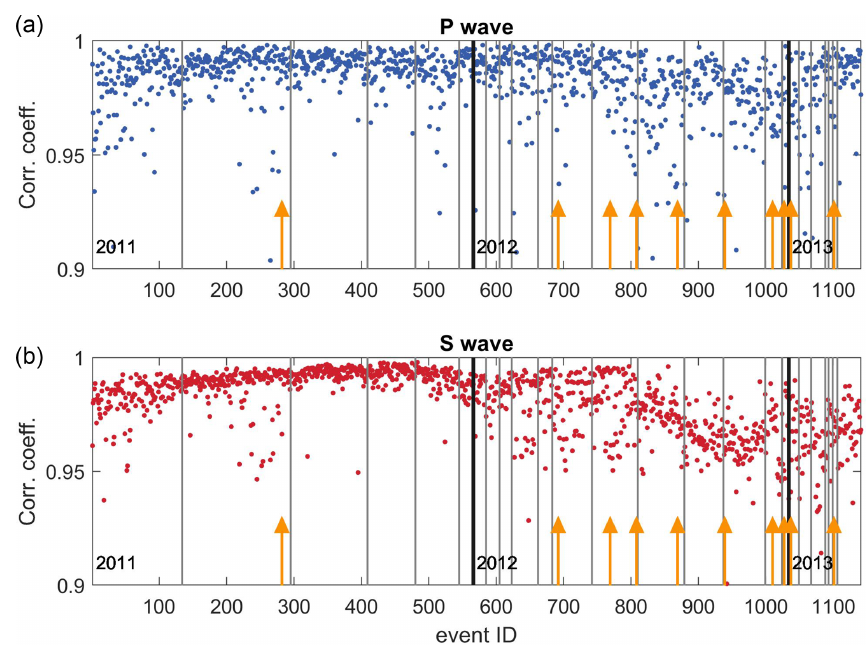
Figure 6. Correlation coefficients for P waves (a) and S waves (b) for each event with respect to the largest event (see Sgattoni et al., 2016a, for details). In each plot, the most probable time occurrences for the 11 relevant changepoints are also reported (yellow arrows).